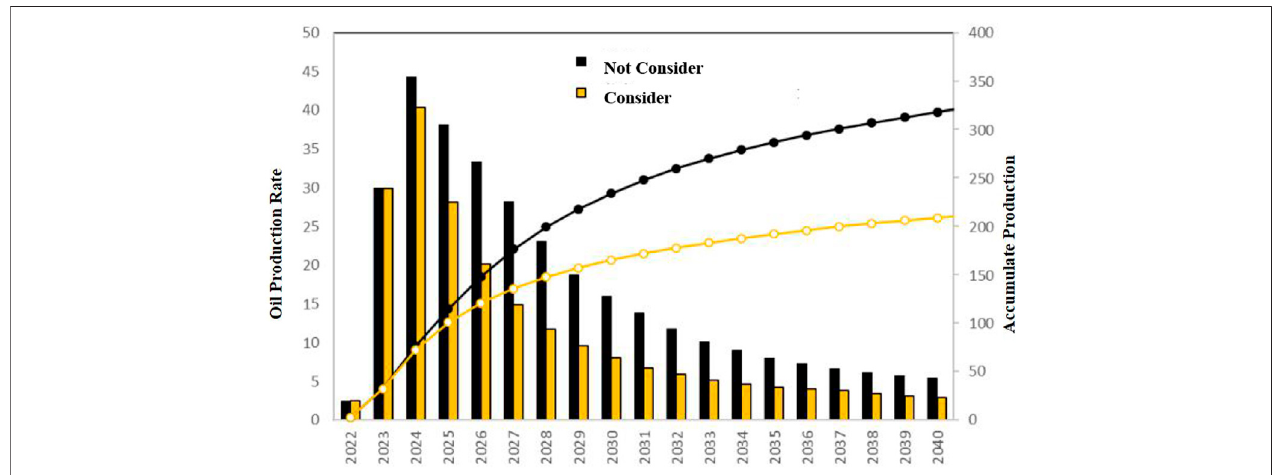
FIGURE 10 | Effect of stress sensitivity on oil production